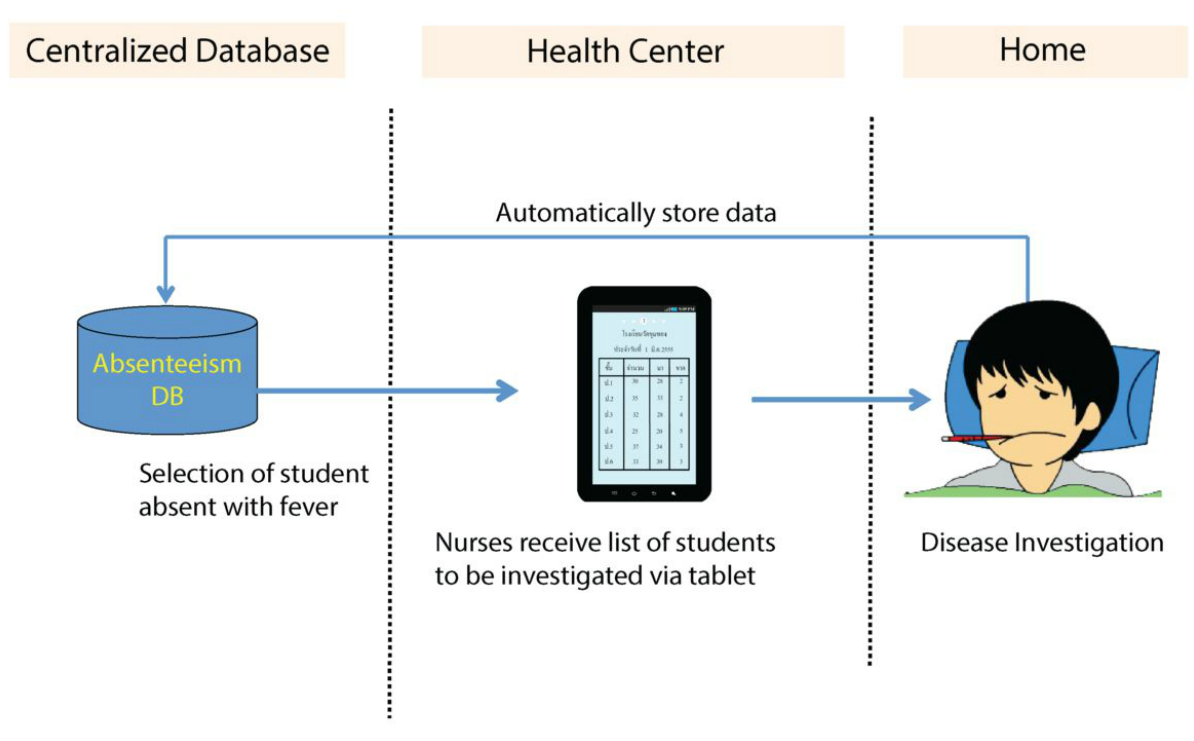
Figure 6. Data and work flow of the disease investigation